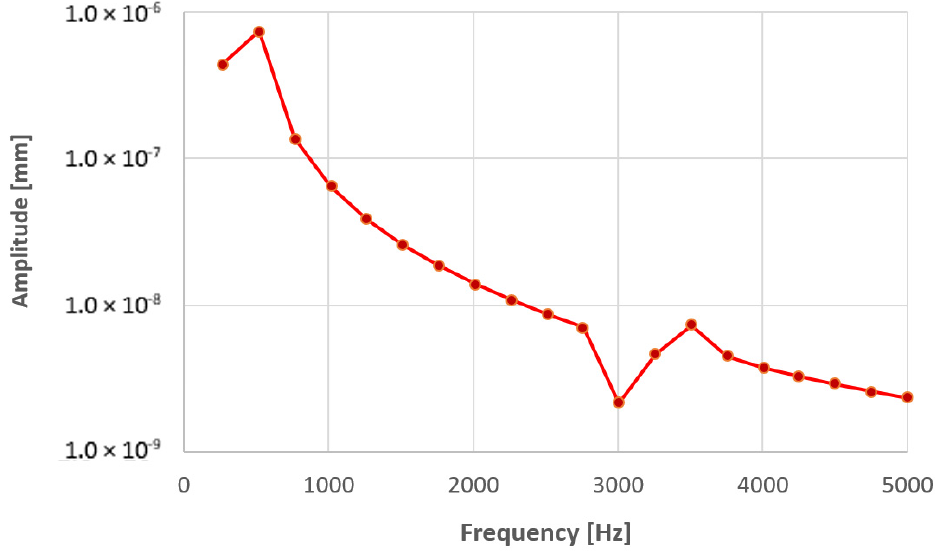
Figure 10. Lateral harmonic response of the wheel. The x -axis of the graph represents the frequencies, while the y -axis represents the amplitudes in terms of the normalized amplitude (mm/N). Figure 10 illustrates the lateral harmonic response results. The wheel structure had a maximum amplitude of 741.669 × 10 − 9 mm at a frequency of 518